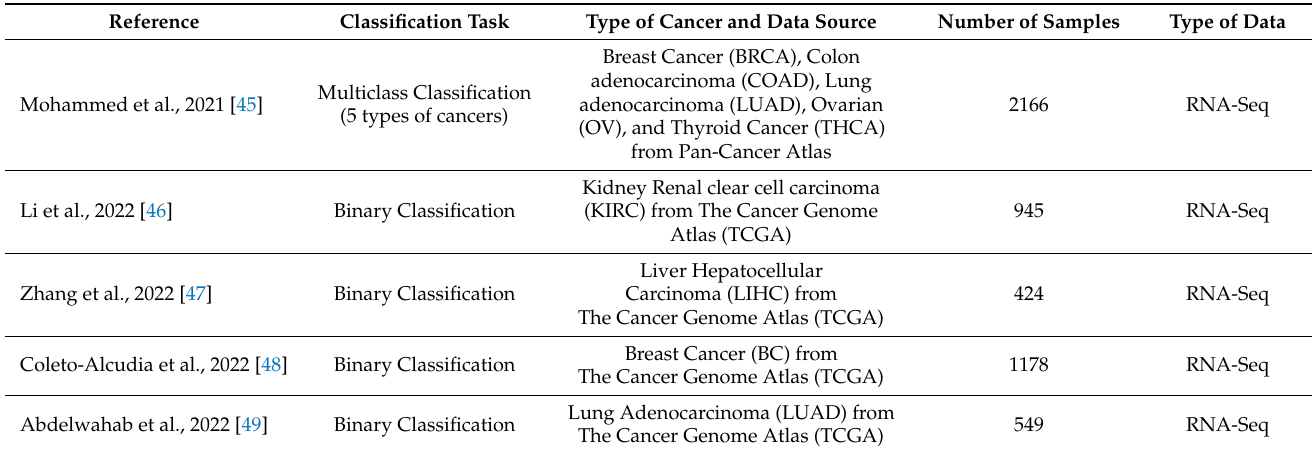
Table 3. Datasets for gene expression